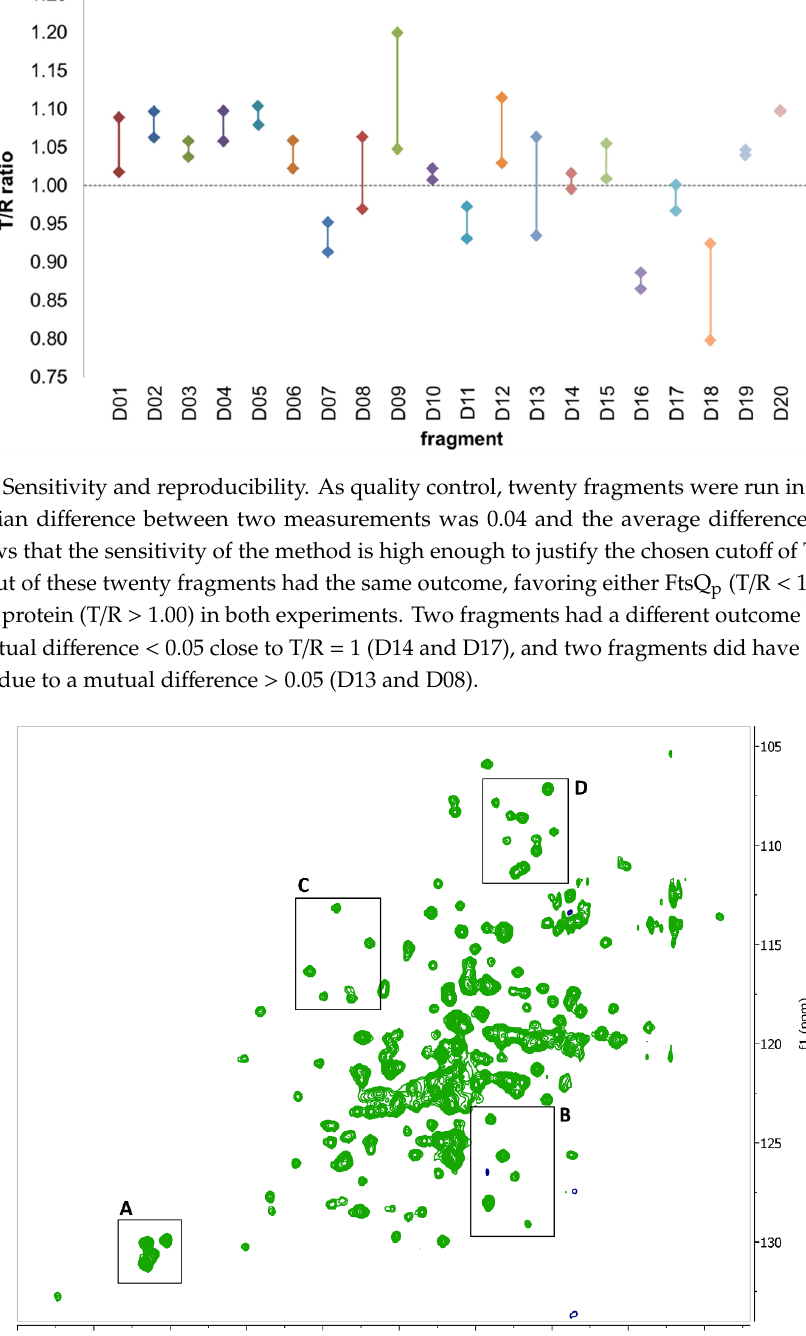
Figure 6. Chemical shift perturbations of FtsQ p with compounds 1, 2 and 3. Each panel shows the superimposed spectra of 200 µM FtsQ p without the fragment (green) and in solution with the